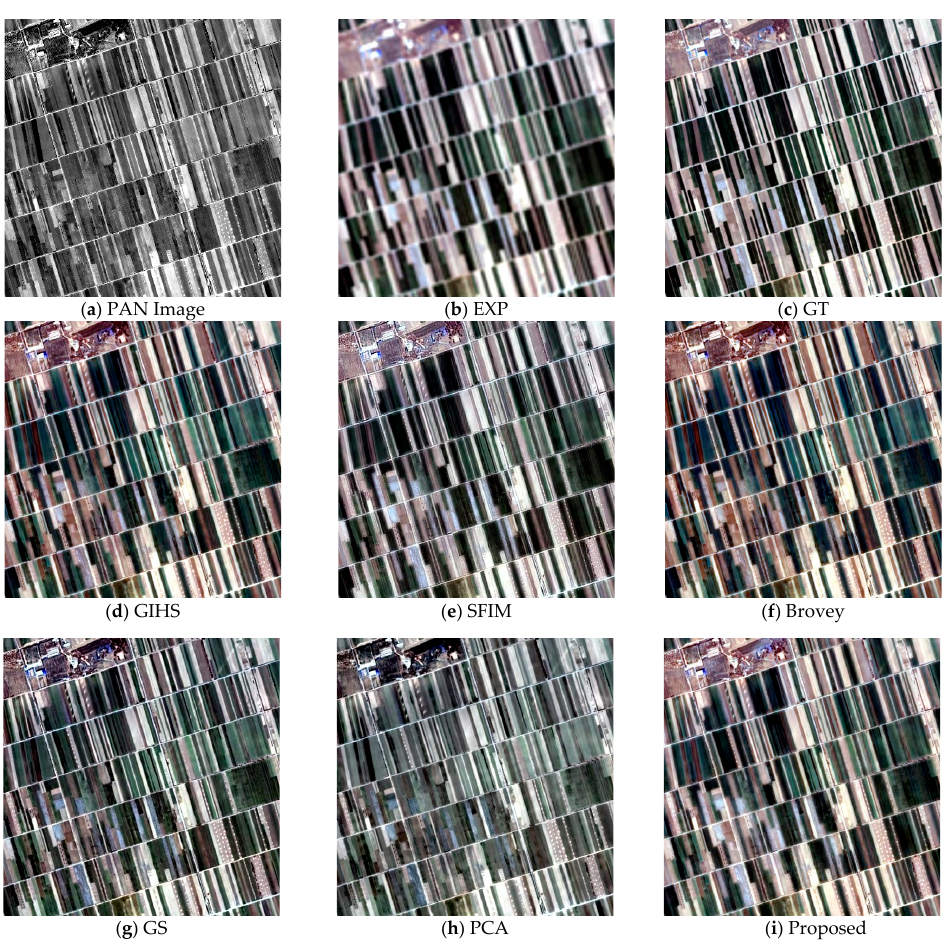
Figure 6. Fusion results for the GF-7 images using different methods.